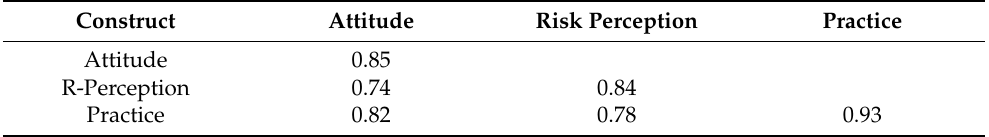
Table 5. The discriminant validity index